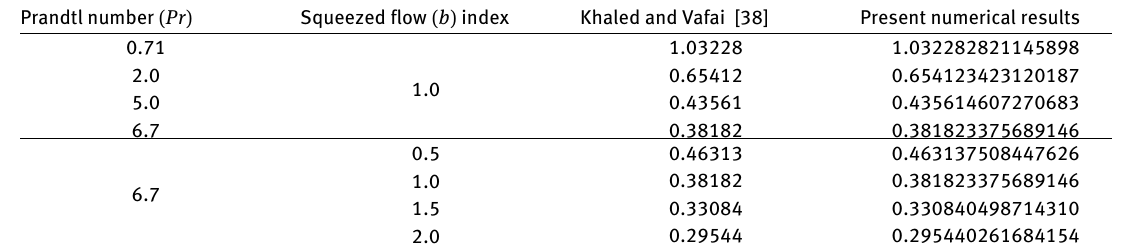
Table 2: Comparison of present similarity solutions with previously published results of Khaled and Vafai [38] for θ (0) with M = f o = ϵ = 0 Prandtl number ( Pr